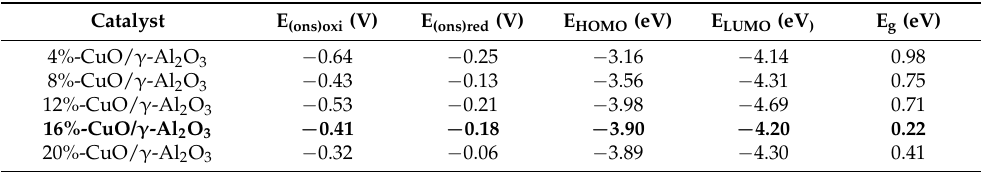
Table 4. Electrochemical bandgap values derived from onset potentials vs. sat’d calomel electrode for AEO on the CuO/ γ -Al 2 O 3